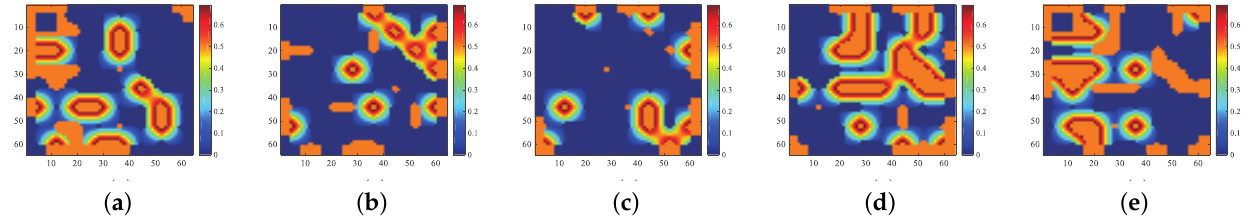
Figure 4. True abundance maps of five endmembers in data 1. ( a ) True abundance map of endmember 1. ( b ) True abundance map of endmember 2. ( c ) True abundance map of endmember 3. ( d ) True abundance map of endmember 4. ( e ) True abundance map of endmember 5.